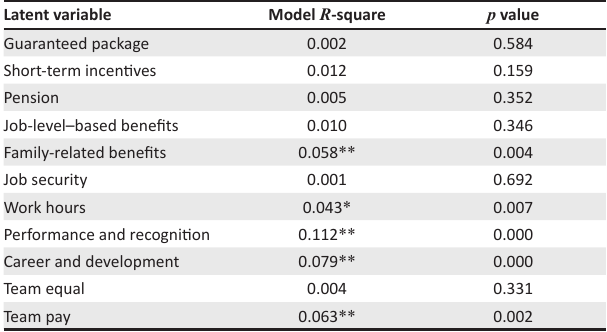
TABLE 8: R -square values for the proposed structural equation modelling theoretical